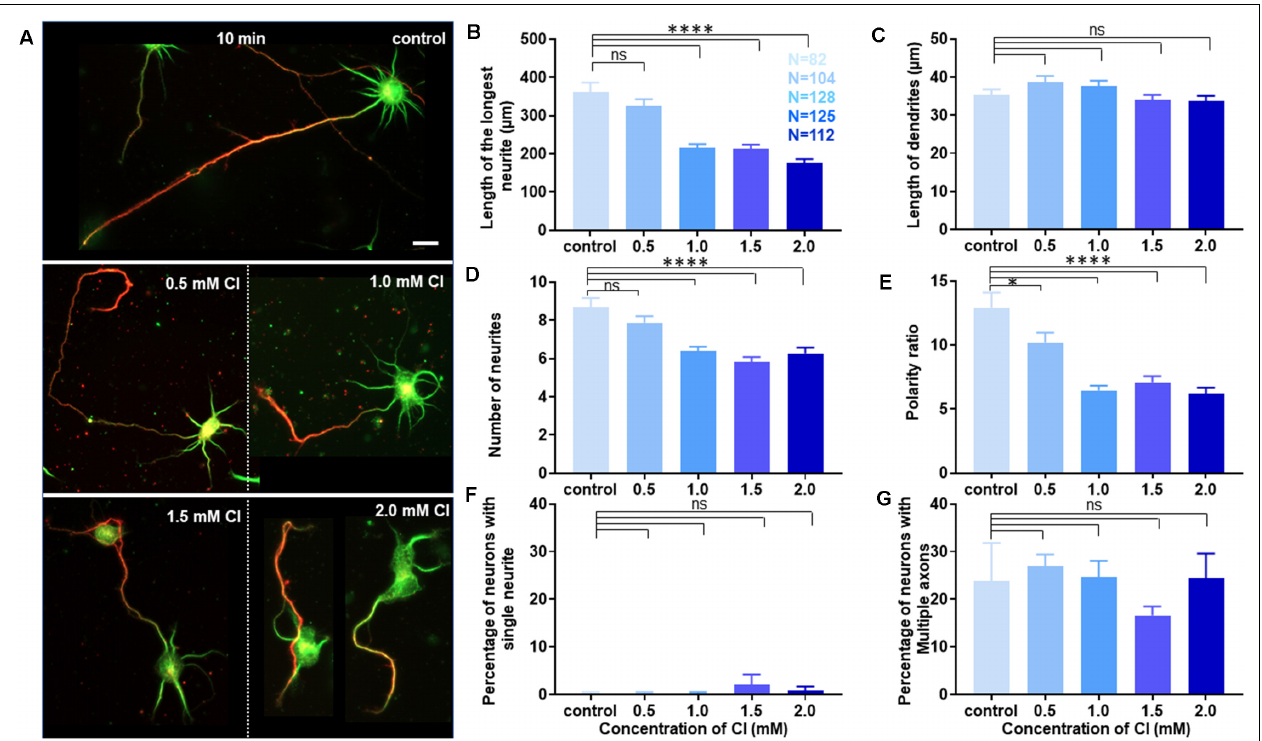
FIGURE 8 | Membrane cholesterol enhancement alters growth but does not shift polarity. (A) A gallery of control and cells transiently treated with varying concentrations of cholesterol (Cl) is presented. Higher cholesterol concentrations altered neuronal architecture and morphology, but also generated cells with axons growing and curling back over the soma. (B–E) Represents the length of the longest neurite (B) , length of dendrites (C) , number of neurites in each cell (D) , and the neuronal polarity ratio (E) of the treated cells. (F,G) Represents the percentage of treated neurons displaying single neurites (F) and supernumerary axons (G) , respectively. Transient membrane cholesterol enhancement significantly perturbed axonal growth and neurite arborization but did not hamper dendritic growth. The neuronal polarity ratio shifted to lower values upon cholesterol enhancement, denoting symmetric growth. Interestingly, there was no significant population of treated neurons with single neurites or displaying multiple axons, confirming that cholesterol enhancement complemented dendritic extension, but not polarity shift to develop supernumerary axons. N denotes the number of cells from three independent cultures. One-way Anova was performed to test the significance of the difference between the means. ∗∗∗∗ p < 0.0001, ∗ p < 0.05, and ns non-significant. Scale bar indicates 20 µ m.